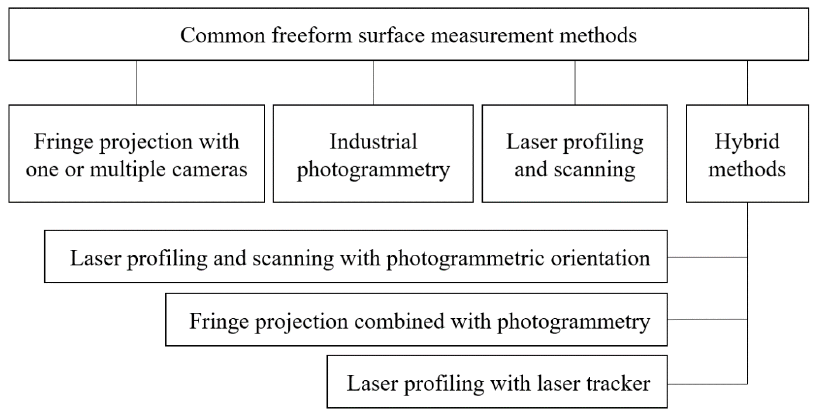
Figure 7. Common freeform surface measurement methods.